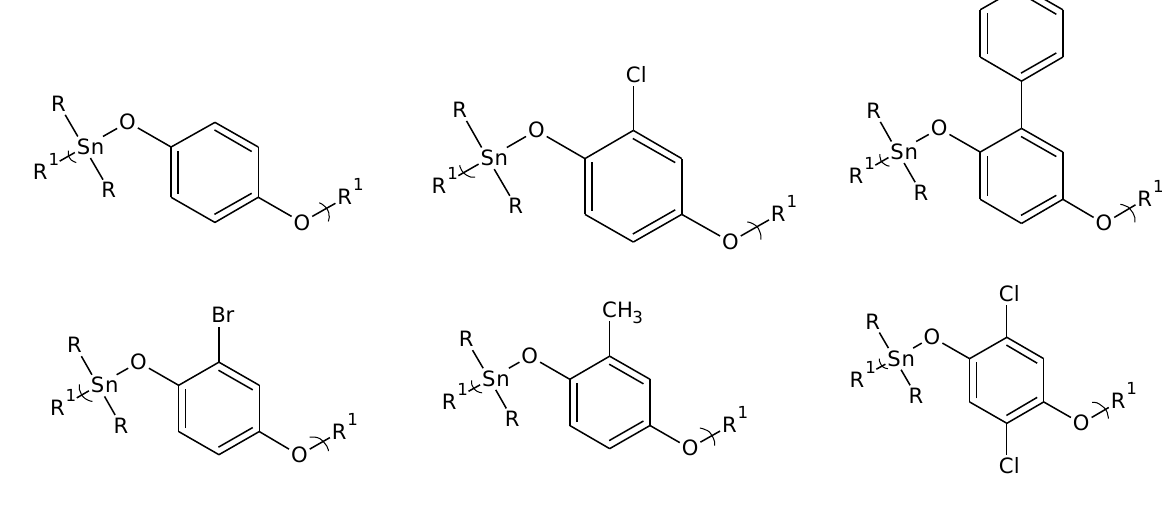
Figure 2. Representative structures for some of the hydroquinone and hydroquinone- derived polyethers. The diols are from left to right, top: hydroquinone itself, chlorohydroquinone, phenylhydroquinone, and left to right, bottom: bromohydroquinone, methylhydroquinone, and 2,5-dichlorohydroquinone where R is butyl and R 1 represents simple chain